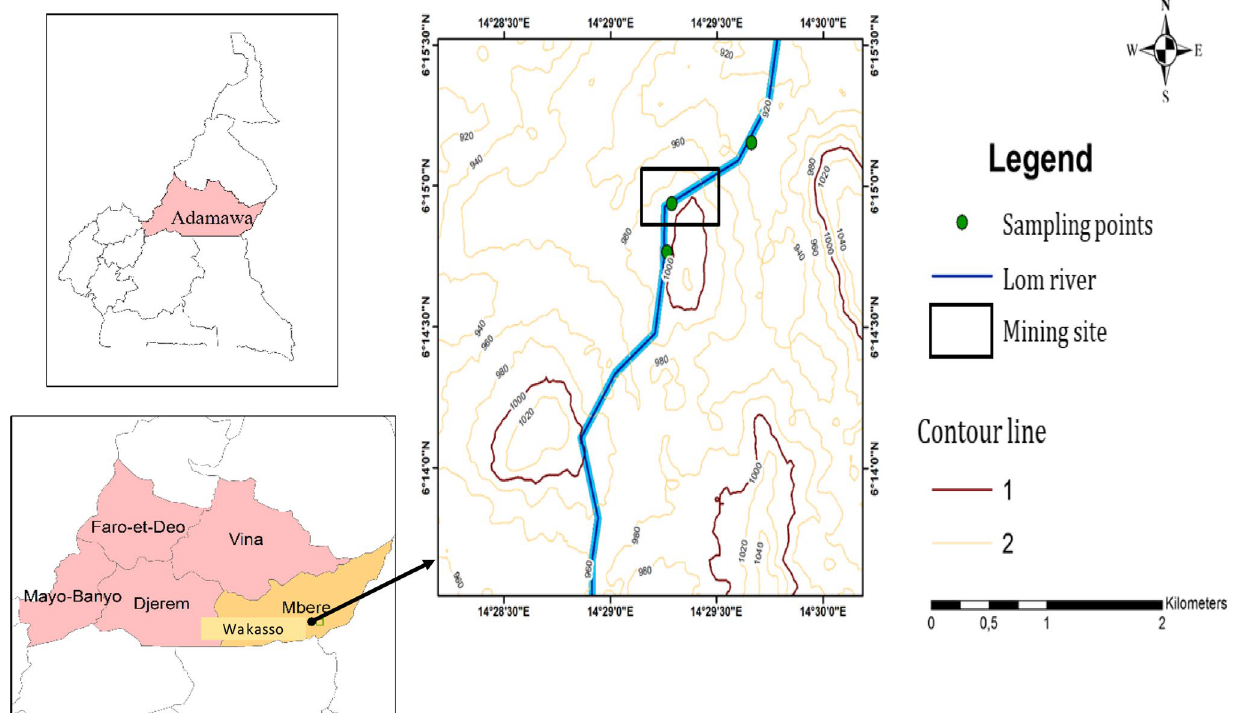
Fig. 1 Location map of the study area and sampling